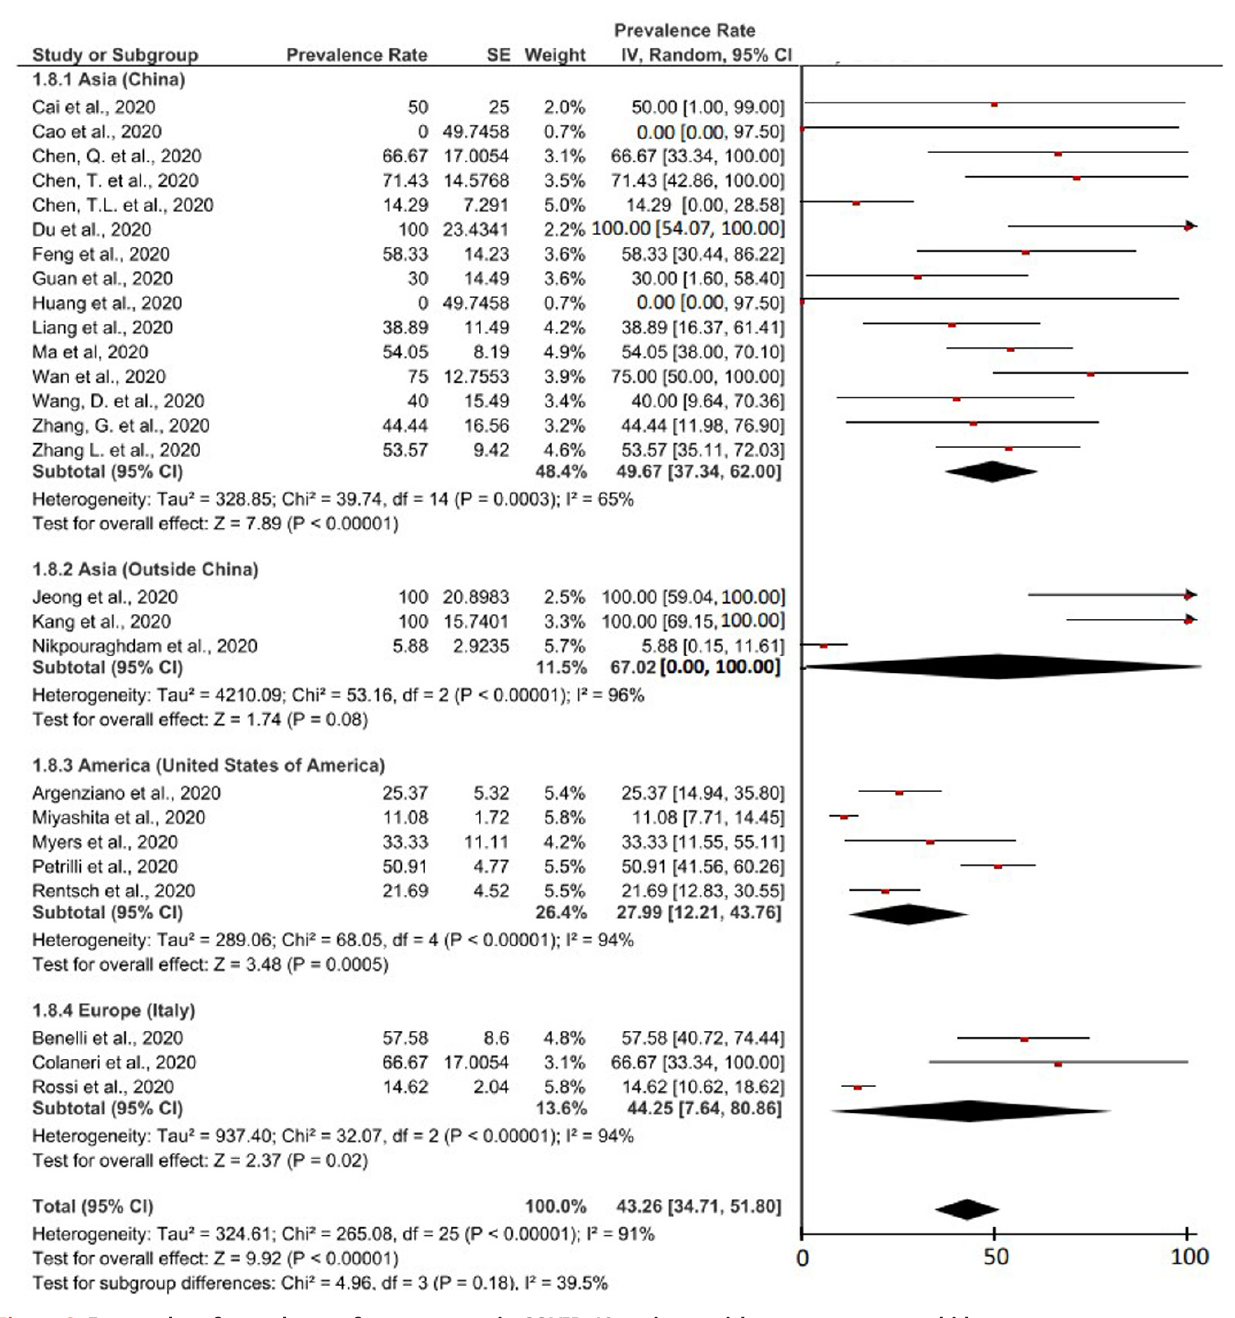
Figure 3. Forest plot of prevalence of severe event in COVID-19 patients with cancer as a comorbid.